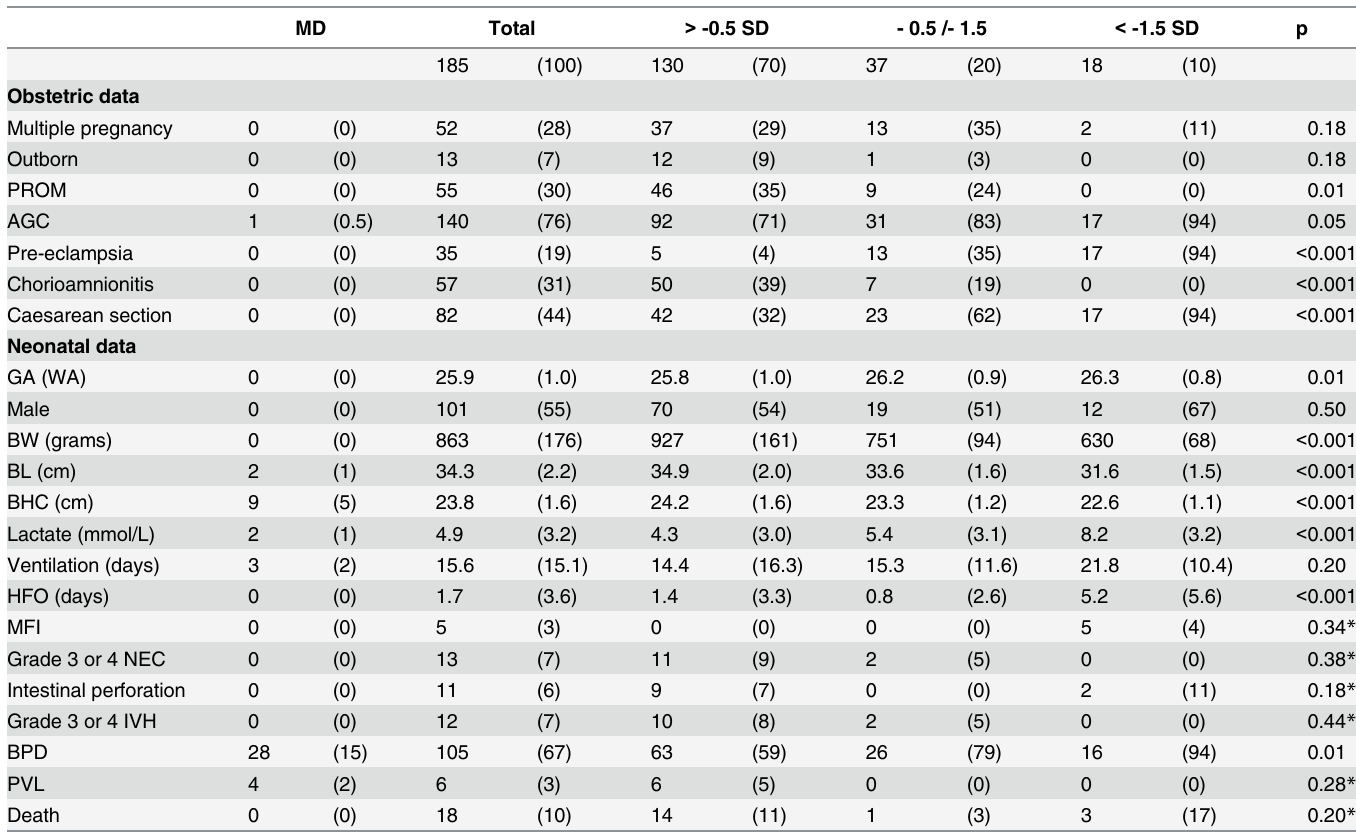
Table 1. Baseline